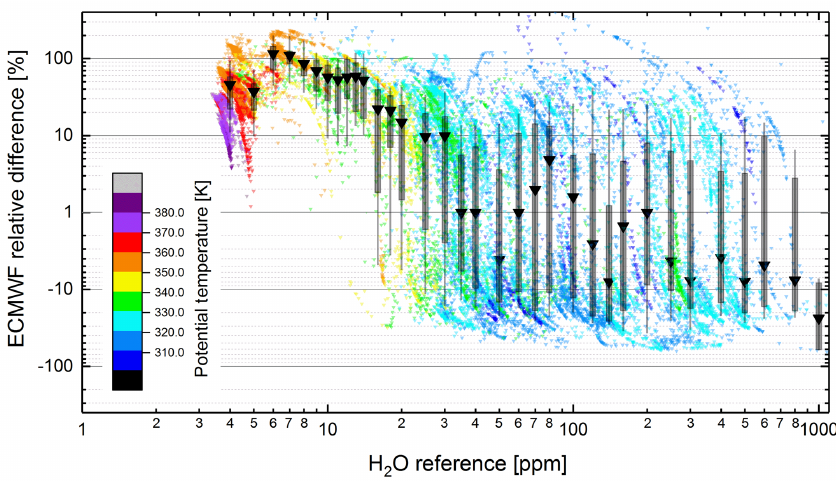
Figure 7. Relative difference of H 2 O mixing ratio between ECMWF analysis and measurement reference for all ML-CIRRUS flights. Model data are interpolated in space and time on each flight track. The reference value on the x axis is the same as in Fig. 4. As in Fig. 4, the triangles, broad bars and narrow bars represent the mean values, 25th–75th percentiles and 10th–90th percentiles, respectively. Single data points are color-coded with potential temperature.